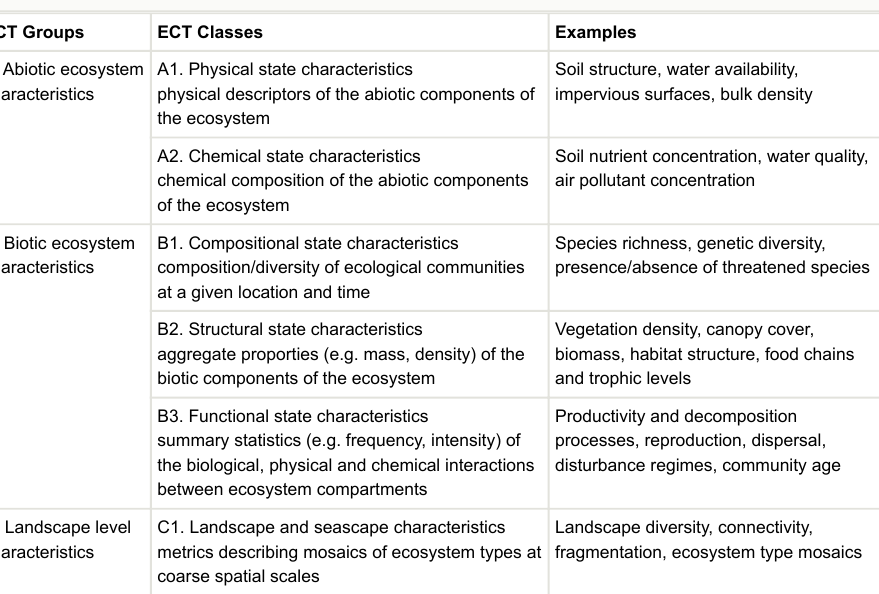
Ecosystem condition typology for classification of ecosystem characteristics and associated metrics in the